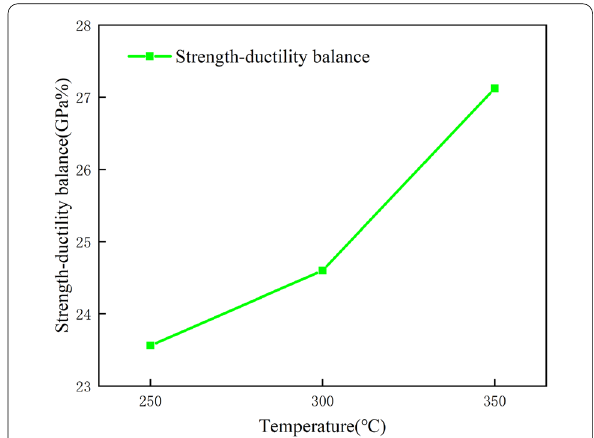
Figure 15 Strength and ductility with different quenching temperatures